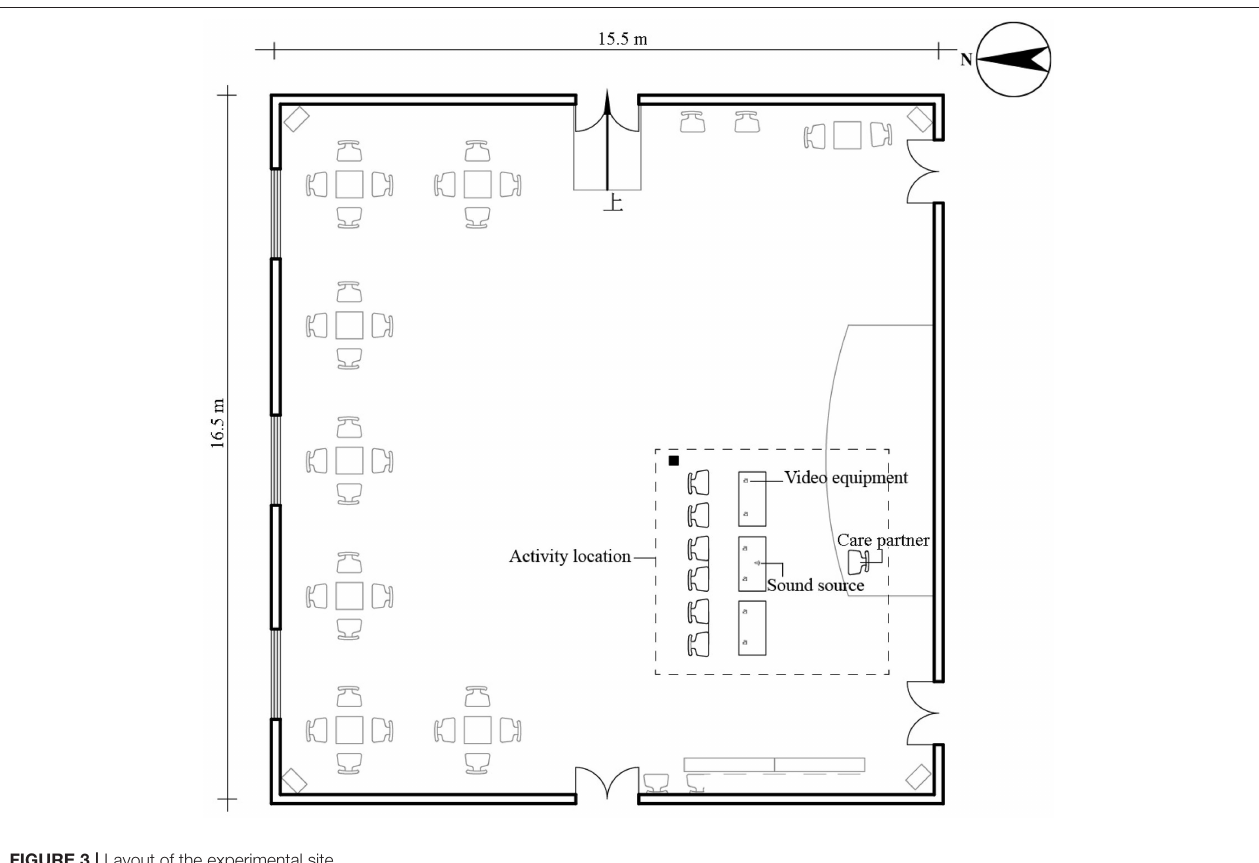
FIGURE 3 | Layout of the experimental site.